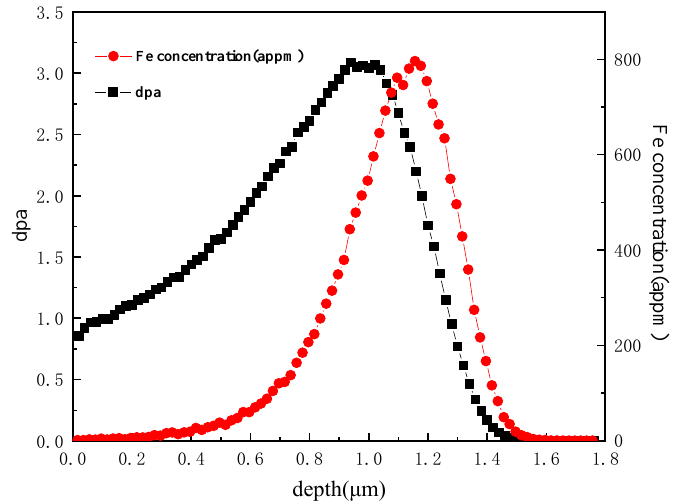
Figure 1. The damage profile calculated for Fe-9Cr alloy irradiated with a 3.5 MeV Fe 13+ ion by using SRIM2013.